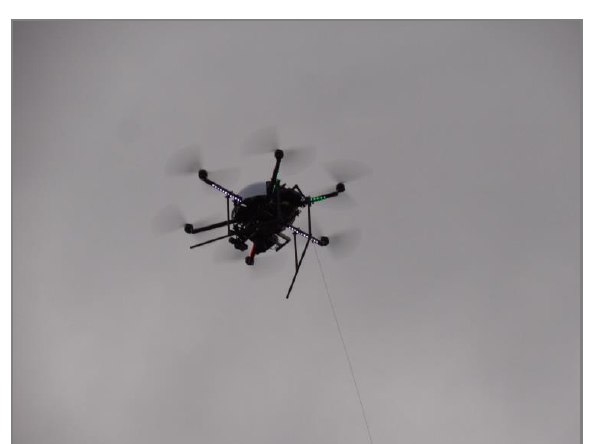
Figure 6. UAV with a tether